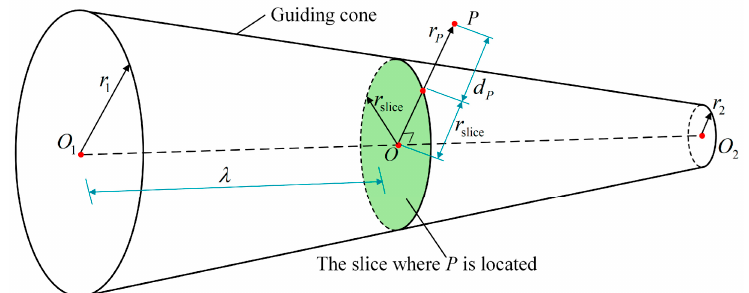
Figure 6. Definition of the distance from point 𝑃 to the guiding cone.